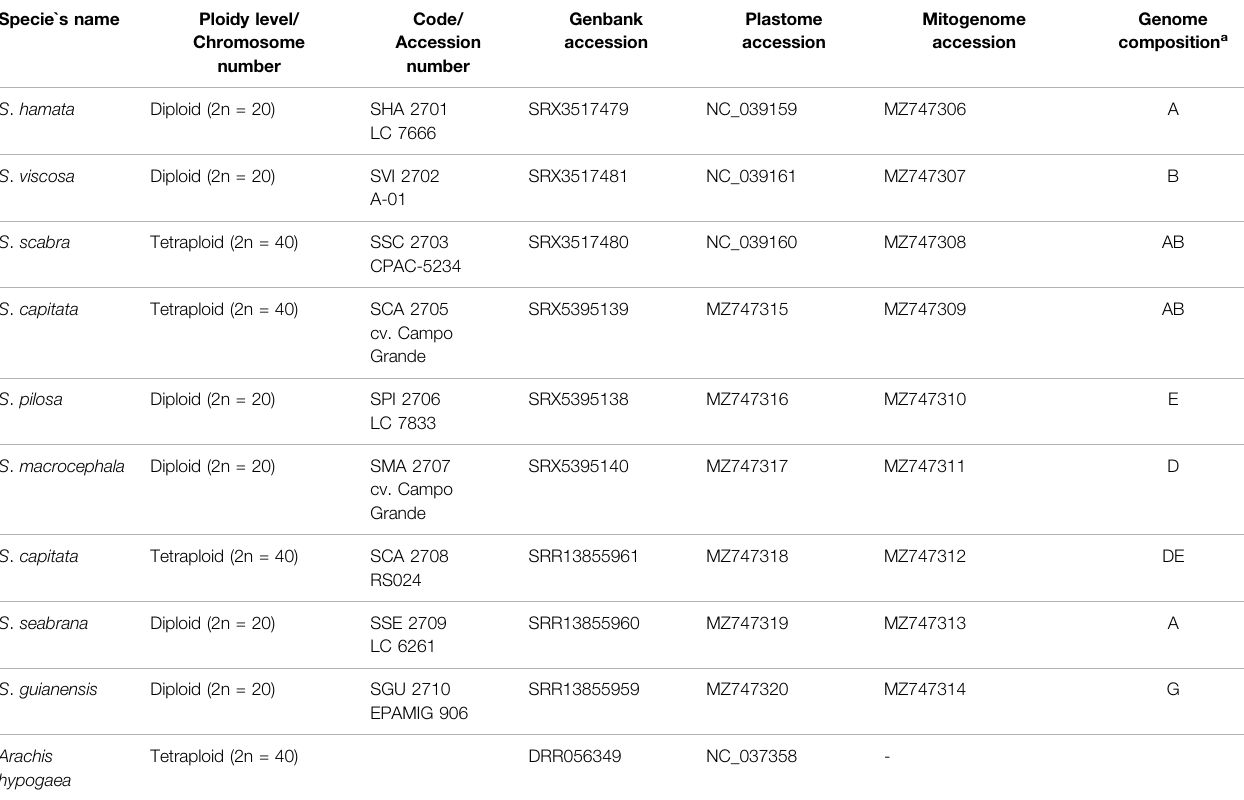
TABLE 1 | List of accessions, ploidy level, reference number, SRA, plastome and mitogenome accession numbers and genome composition. Specie`s